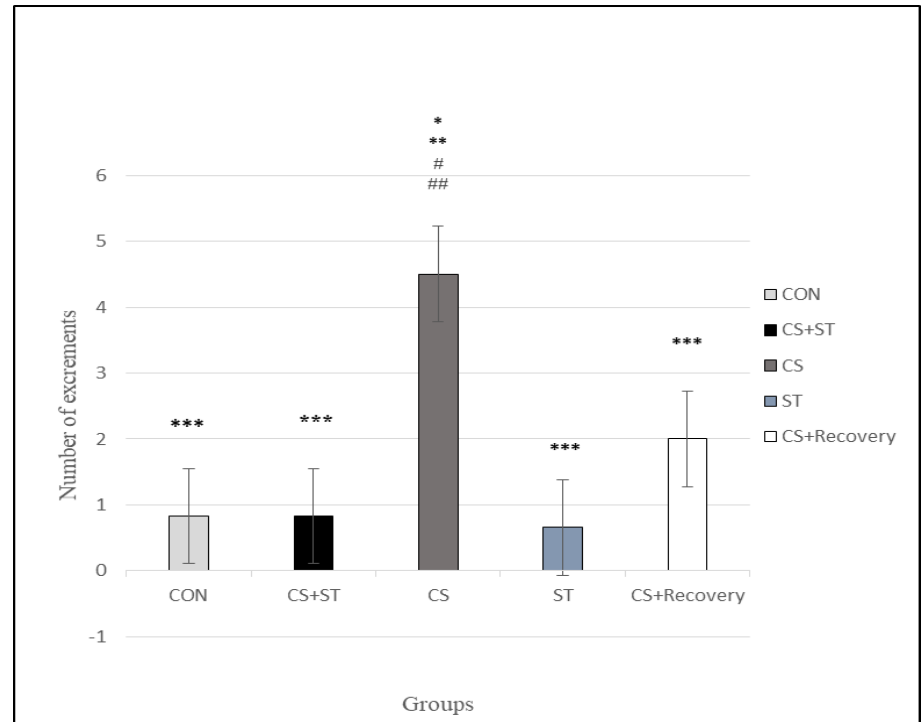
Figure 9. Number of excrements in male rats. Data are expressed as the mean ± S.E.M. * p < 0.001 significantly different from the control group. ** p < 0.001, significantly different from the CS + ST group. *** p < 0.001, significantly different from the CS group. # p < 0.001, significantly different from the ST group. ## p < 0.001, significantly different from the CS + Recovery group. CS + ST: exposed to